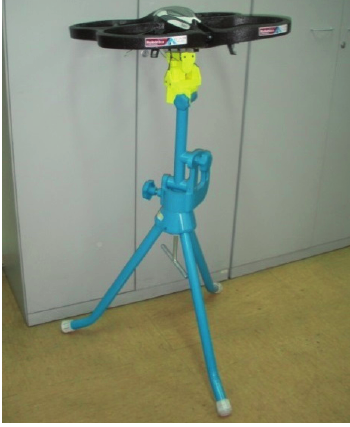
Figure 6. Layout of the experiment